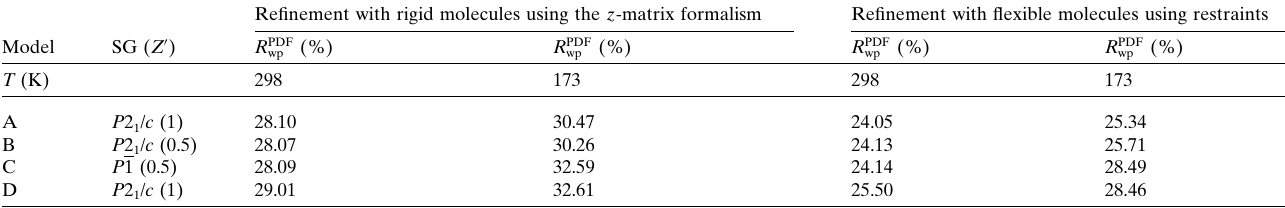
Table 5 Structure refinement of models A–D by fit to the PDF, using different datasets and refinement procedures. Refinement with rigid molecules using the z -matrix formalism Refinement with flexible molecules using restraints